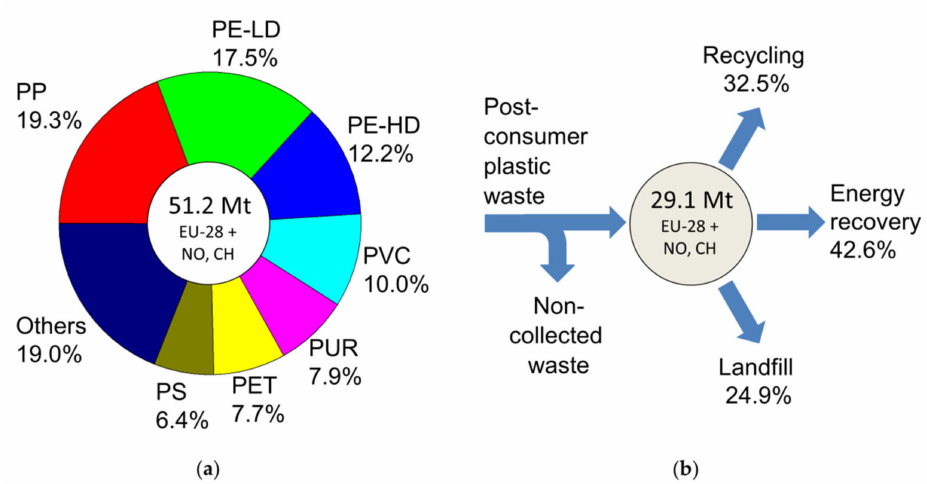
Figure 4. ( a ) European plastics demand distribution by resin type in million tons (Mt) in 2018. ( b ) Distribution of post- consumer plastic waste in Europe in 2018. Data taken from